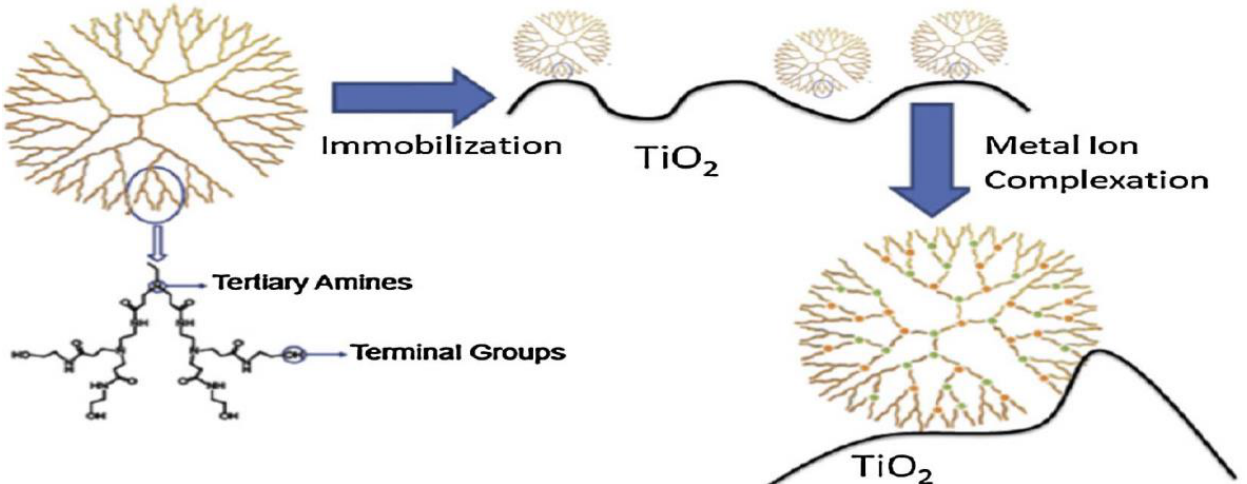
Figure 1. Strategy for immobilizing G4-OH dendrimers on titania to produce dendrimer/titania composites. Reprinted with permission from [12]. Copyright (2013) Elsevier Ltd.